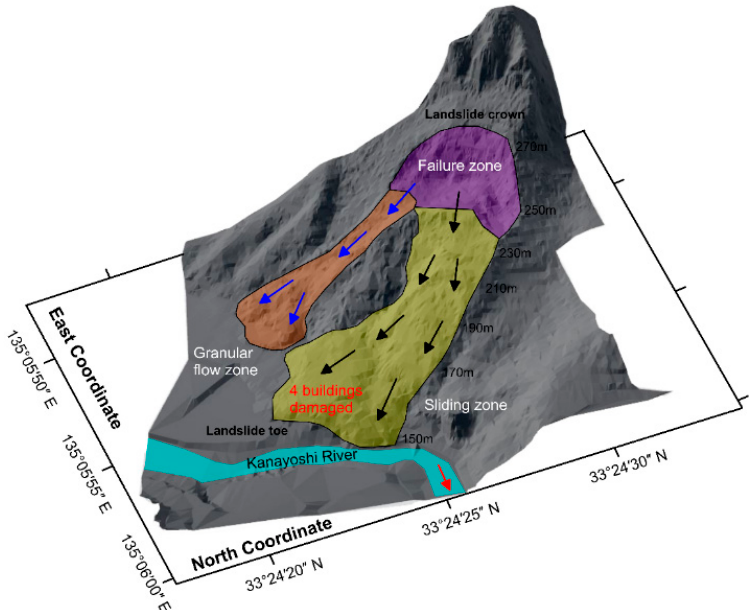
Figure 3. Sub-zones of the 2018 Yabakei landslide.